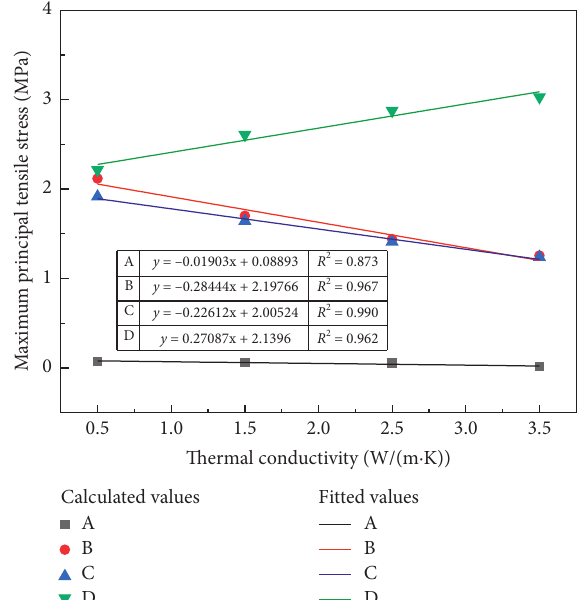
Figure 5: The calculated and fitted maximum principal tensile stress at each point with a different thermal